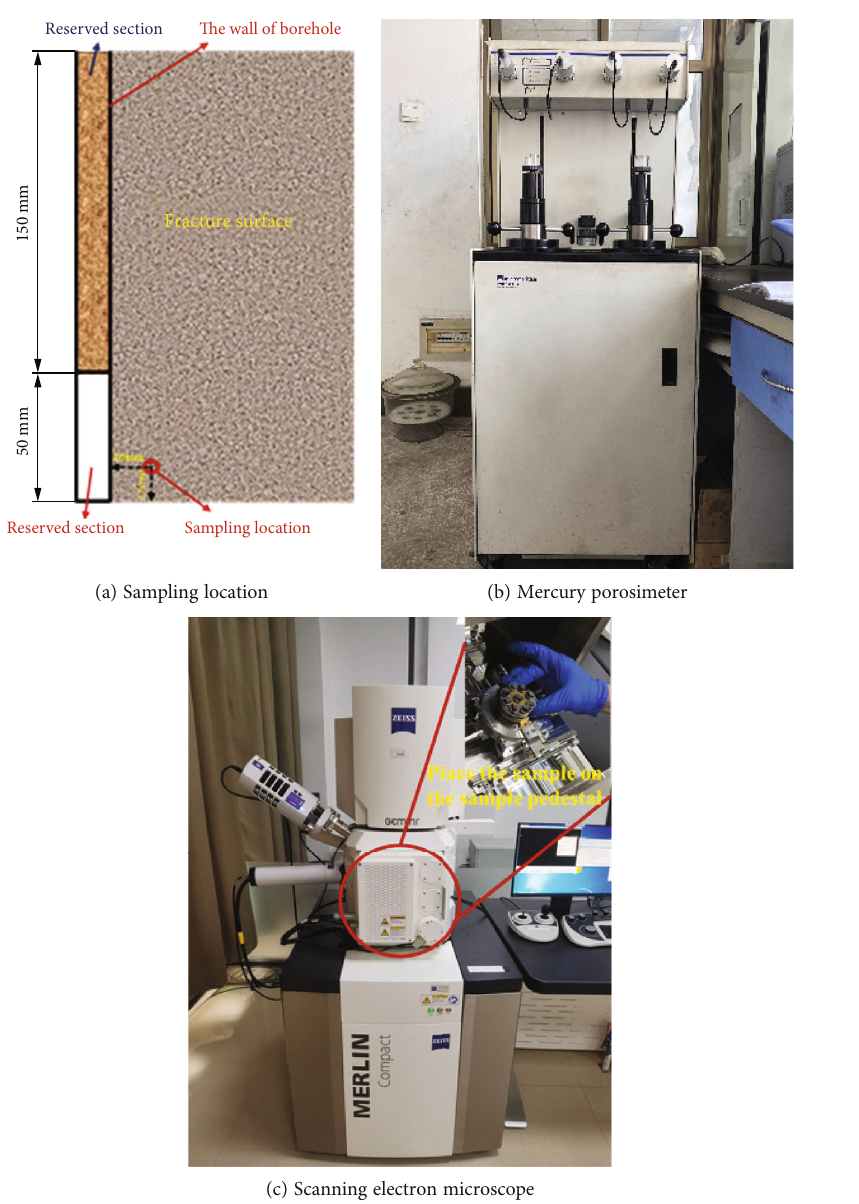
Figure 3: Sampling location and test